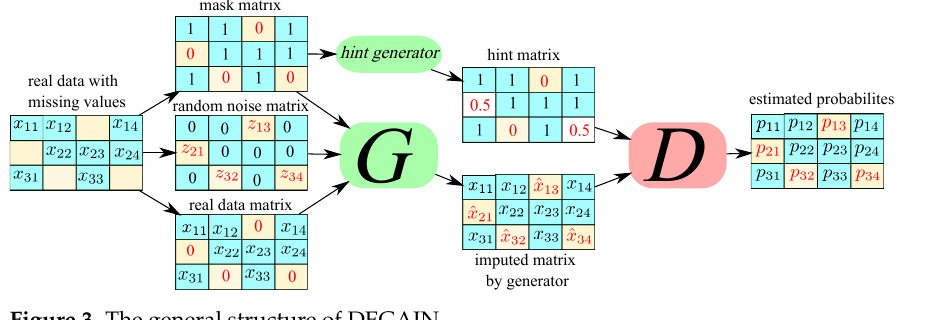
Figure 3. The general structure of DEGAIN. Algorithm 1 (The DEGAIN algorithm: deconvolution and then